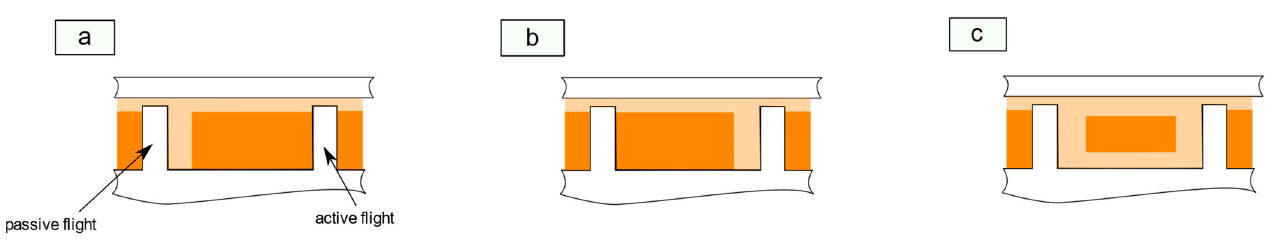
Figure 9. ( a ) Klenk; ( b ) Maddock; ( c ) Lindt melting mechanism.